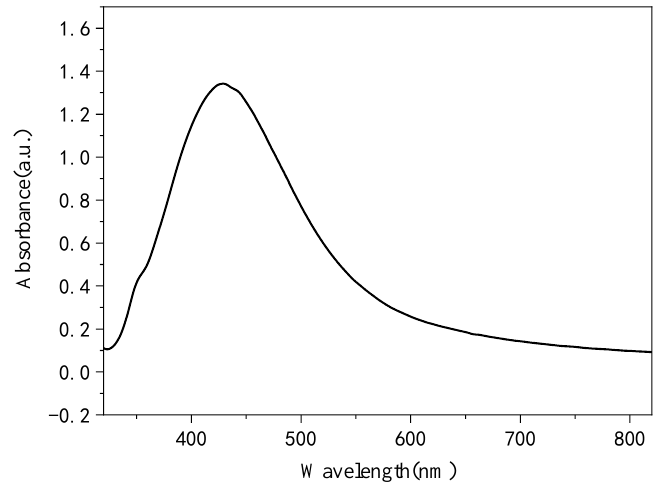
Chemosensors 2022 , 10 , x FOR PEER REVIEW Figure 1. UV-V is spectrum of A g NP s prepared with 1 mM and 5 mM AgNO 3 . Figure 1. UV-Vis spectrum of Ag NPs prepared with 1 mM and 5 mM AgNO 3 .